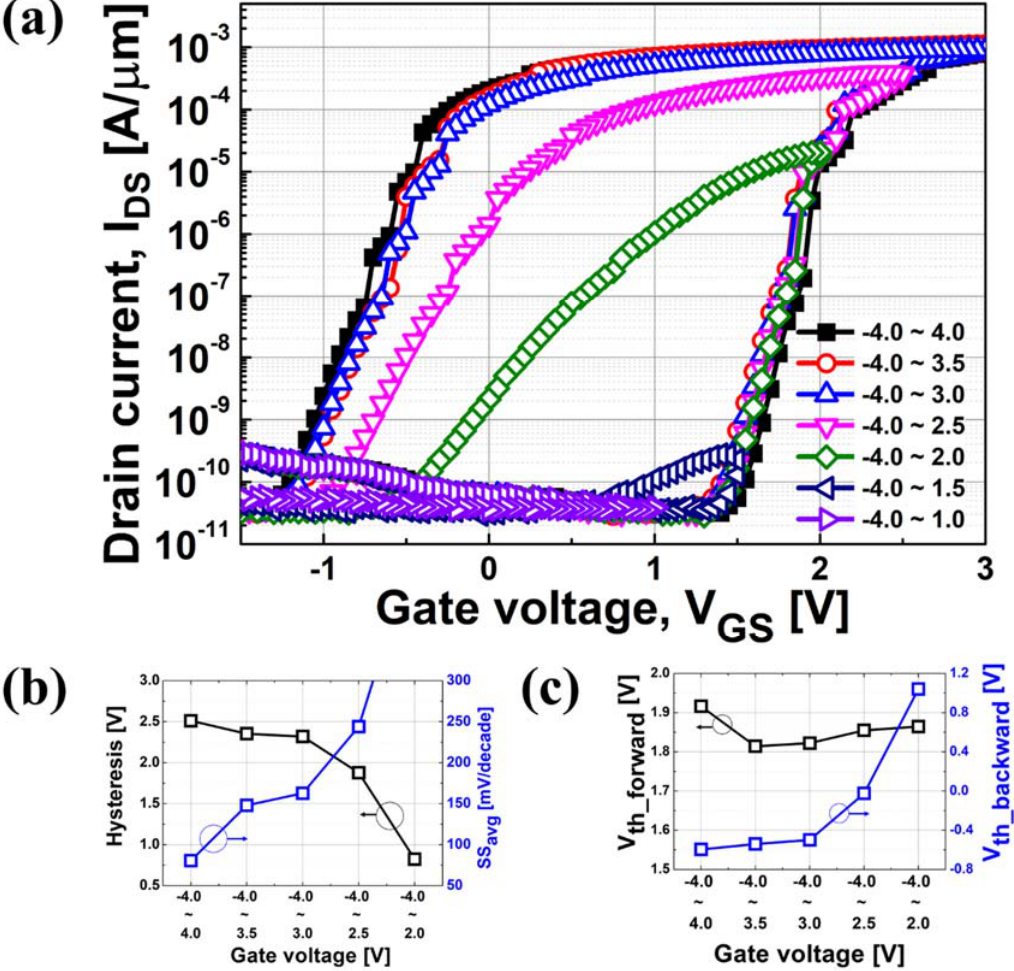
Figure 4. ( a ) Measured drain current versus gate voltage for various V GS_positive (i.e., from 4 to 1 V) with the fixed V GS_negative of − 4 V. ( b ) Hysteresis (left-axis) and SS avg_backward (right-axis) versus gate voltage sweep range of the Fe-FinFET. ( c ) V th_forward (left-axis) and V th_backward (right-axis) versus gate voltage sweep range of the Fe ‐ FinFET.